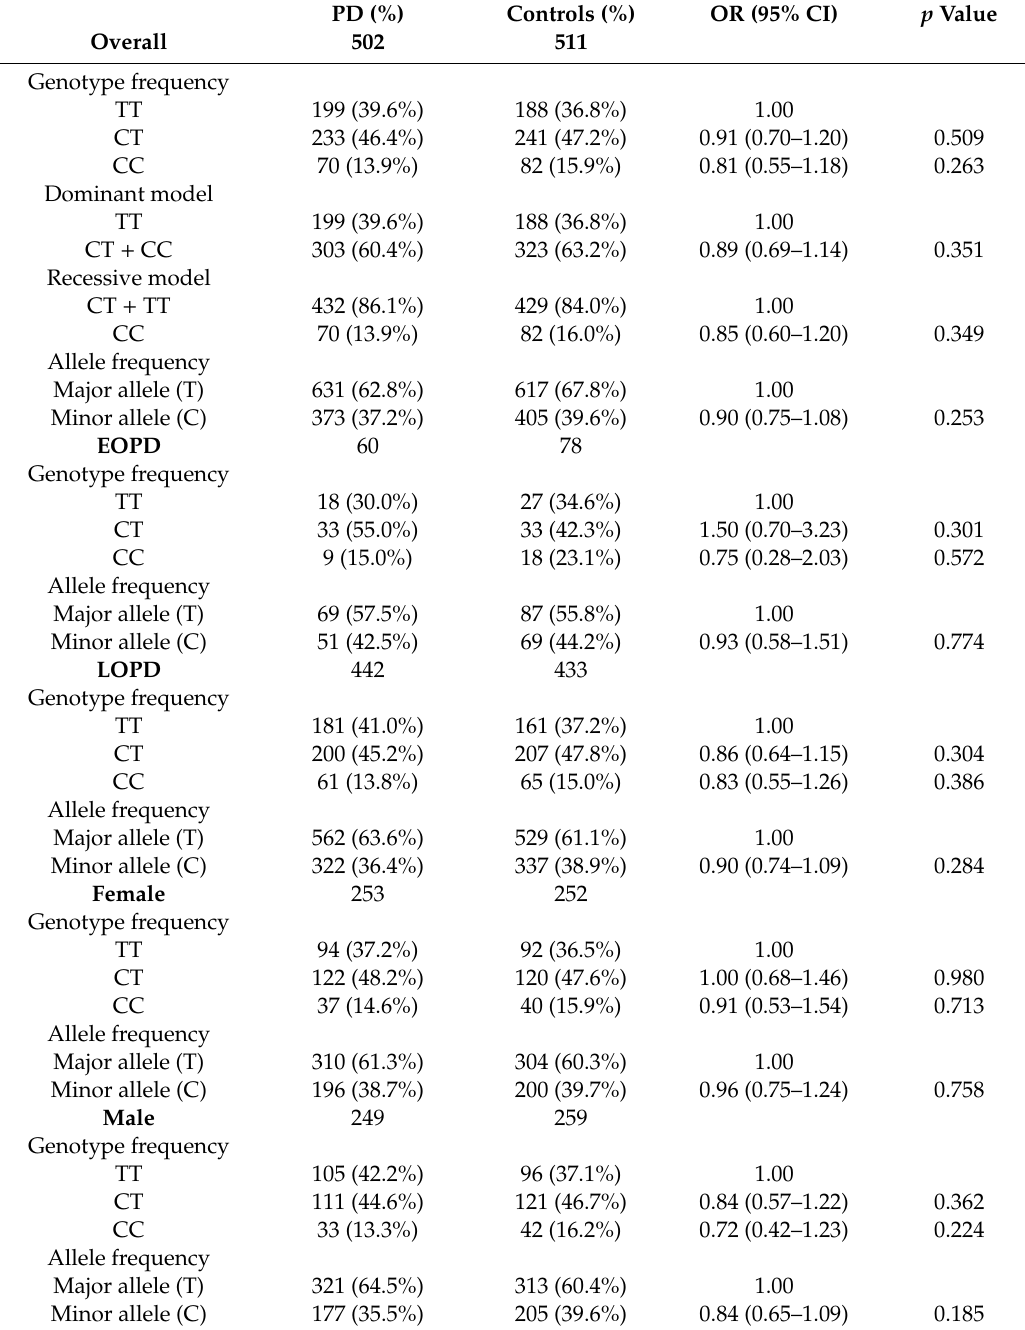
Table 3. Genotype and allele frequencies of the CSF1R rs10079250 polymorphism among Parkinson’s disease (PD) patients and control subjects in